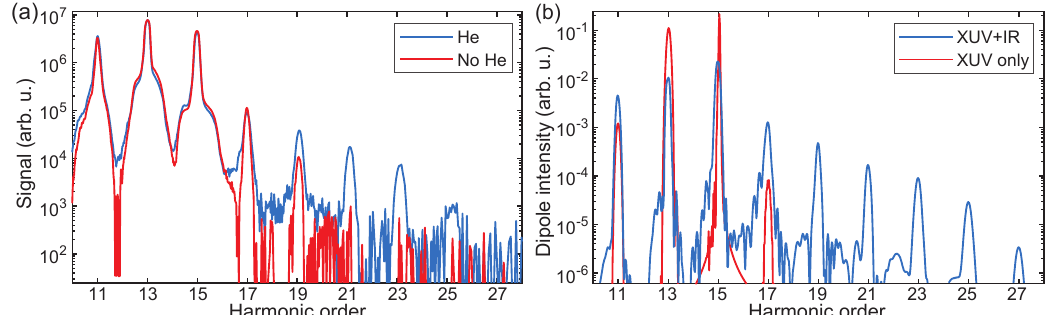
Figure 2. XUV-initiated HHG spectra in experiments and theory. ( a ) Experimental data. Measured spectrum without (red curve) and with (blue curve) helium in the target gas cell. XUV-initiated HHG is clearly visible up to H25. H11–H15 exhibit pronounced pedestal structures that are due to an experimental artifact. ( b ) Time-dependent Schrödinger equation (TDSE) calculation results. Dipole spectrum without (red curve) and with (blue curve) the IR